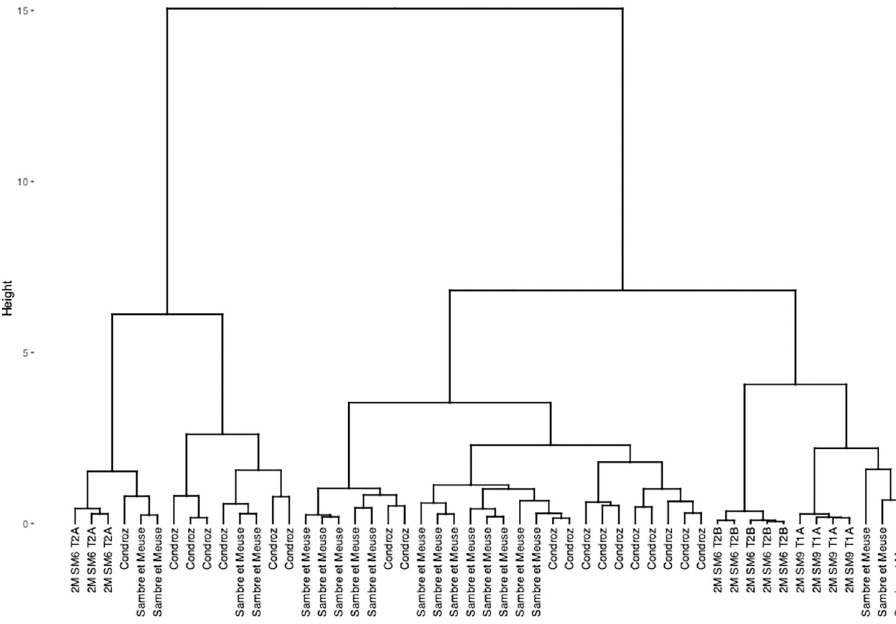
Fig 20. Dendrogram of the HAC analysis of Wallonia slag samples and artefacts 2M SM6 T2B and T2A.